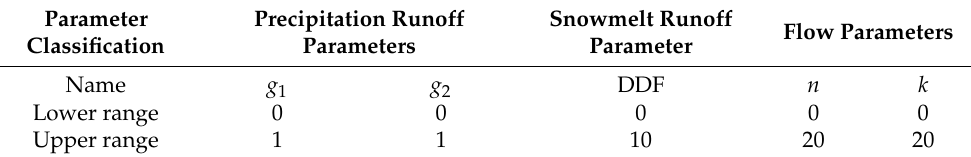
Table 2. Upper and lower limits of the parameters associated with the TVGM-DDF model.